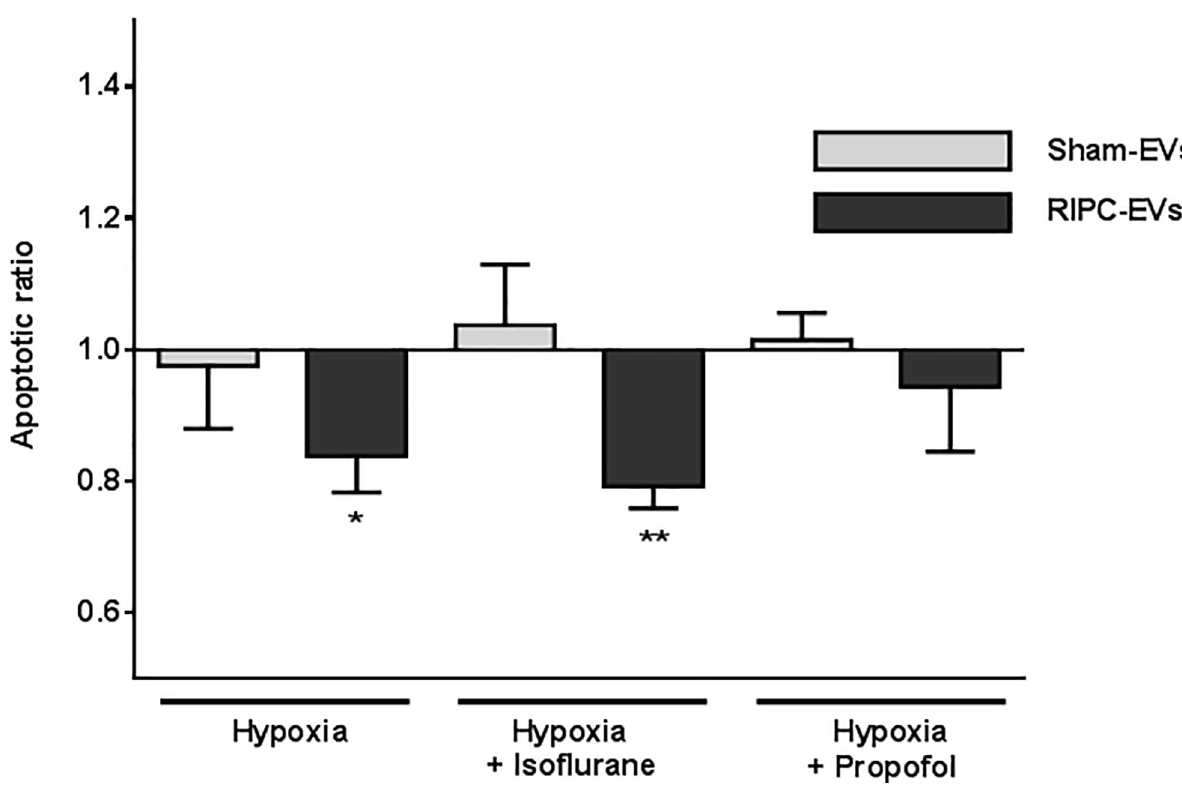
Fig 6. Influence of RIPC-EV or Sham-EV fractions on apoptosis rate in H9c2 cells. EVs were added to H9c2 cells at a concentration of 1x10 9 nanoparticles/ml and incubated for 6 hours before a change of medium and for the following 18 hours of hypoxia. Apoptotic ratio of cells after hypoxia ± isoflurane or ± propofol plus EVs are presented compared to cells without EV incubation. Values are means ± SEM; n = 5 ( � p < 0.05, �� p < 0.01).